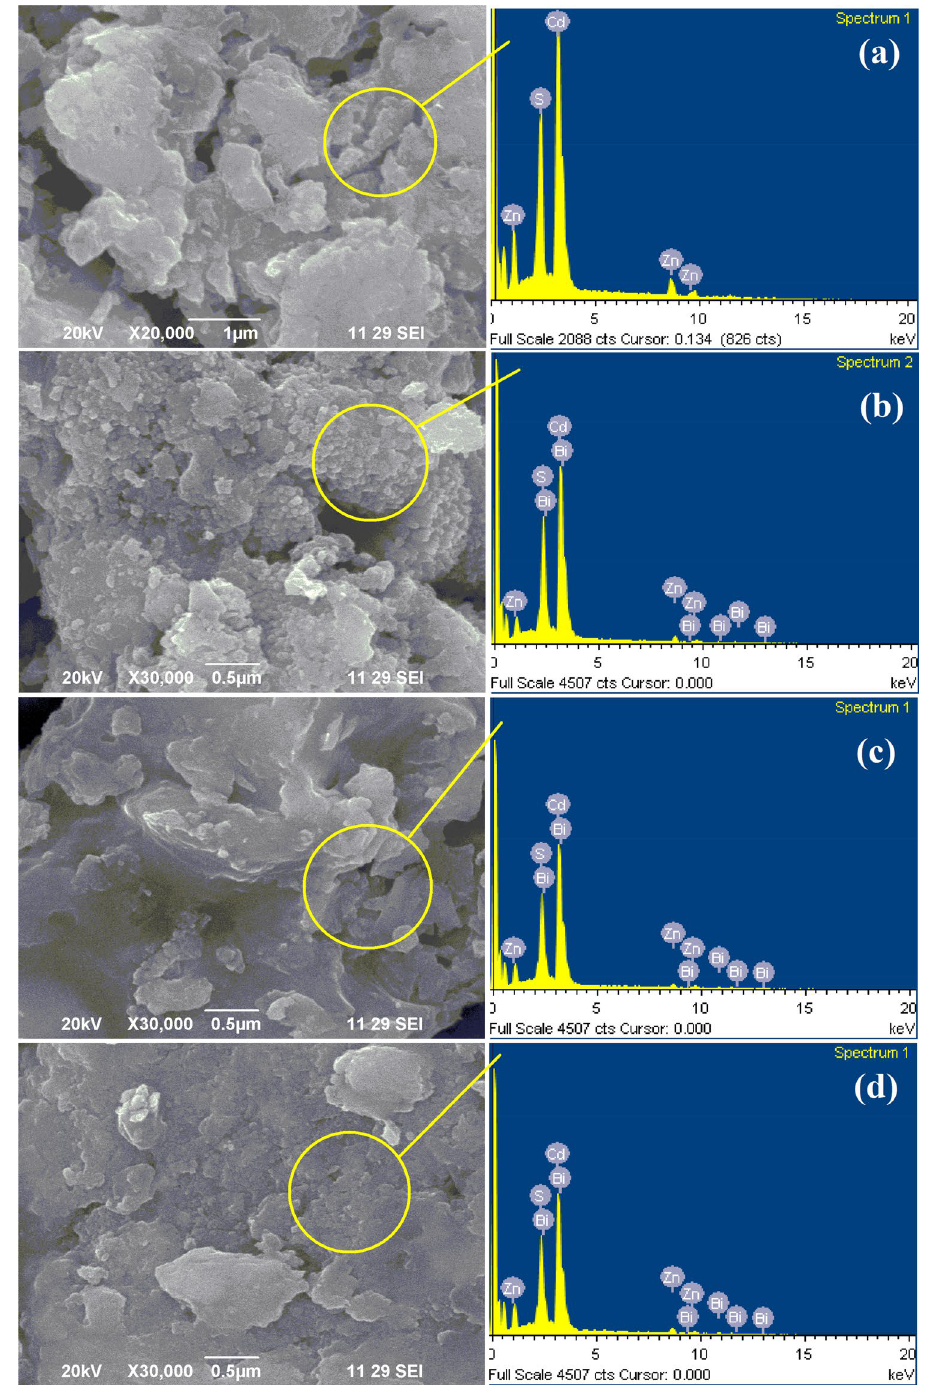
Fig. 4 SEM and EDAX images of